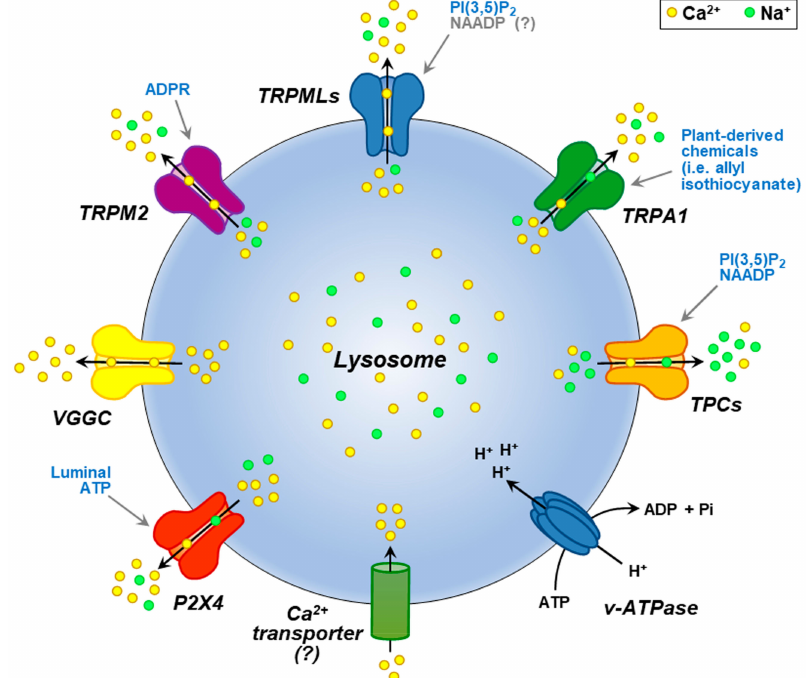
Figure 1. Representation of lysosomal channels and pumps transporting Ca 2 + and Na + ions. Endogenous agonists are reported in light blue for each of them; hypothetical endogenous agonists are reported in grey. Lysosomal proton-pump V-type ATPase ( v-ATPase ) pumping protons into the lumen is also